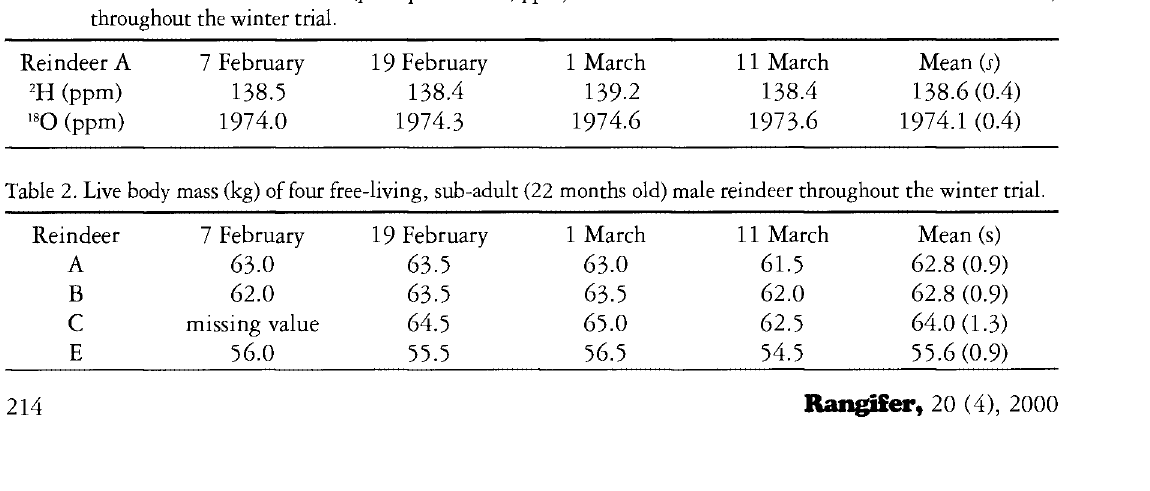
Table 1. Concentration of 2 H and ls O (parts per million; ppm) in the control reindeer (22 months old male reindeer) throughout the winter trial.